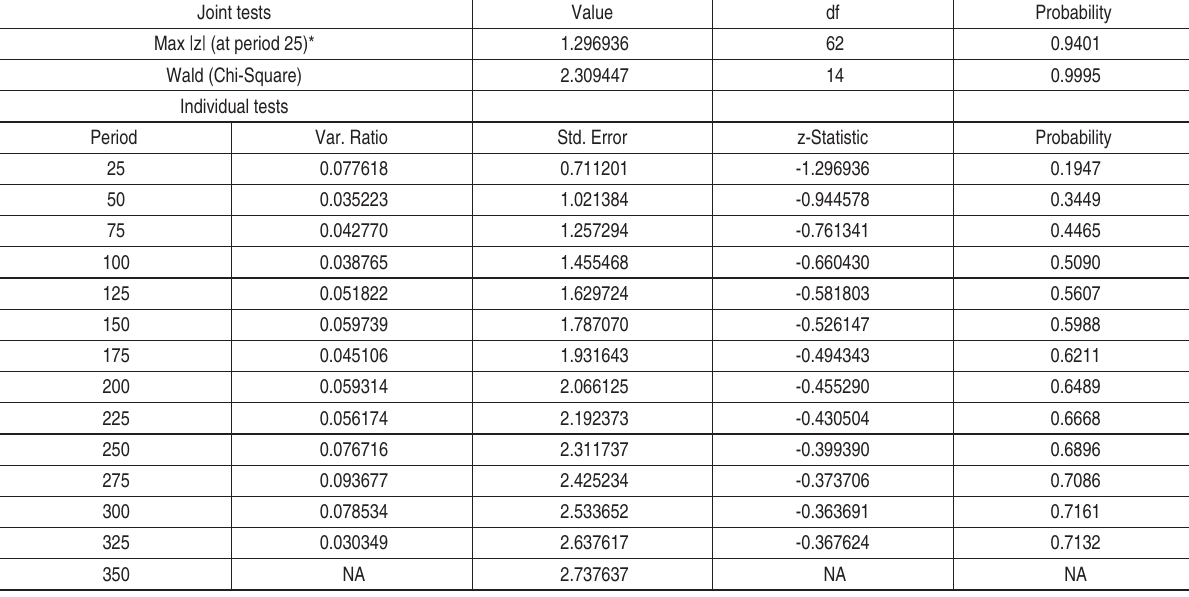
Table 8. Results of the variance ratio test DSE share index weekly